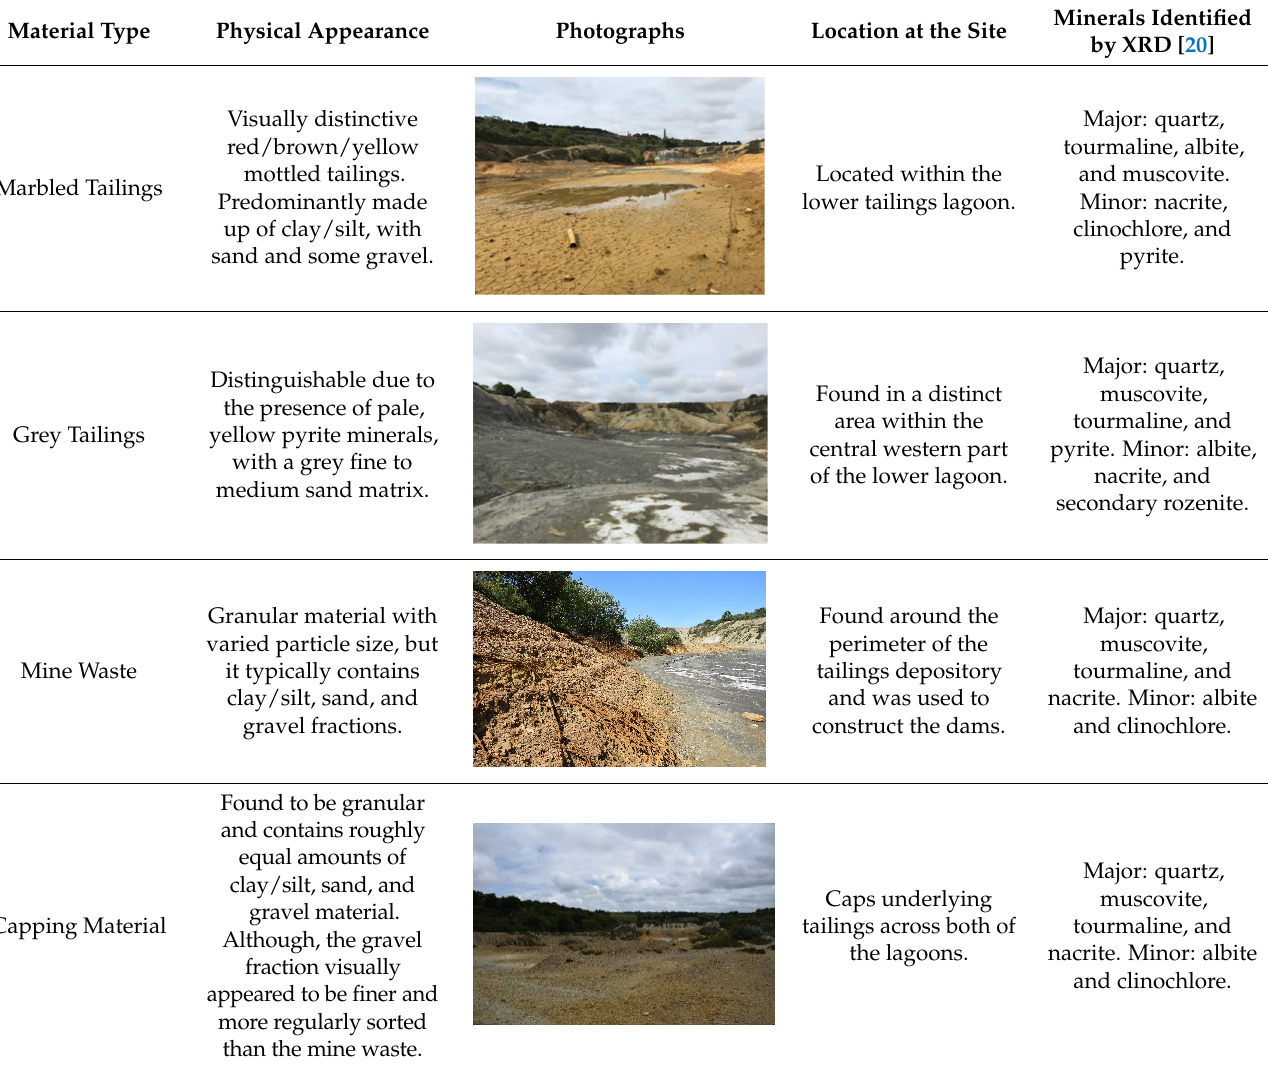
Table 1. The different mine waste types located at Wheal Maid.